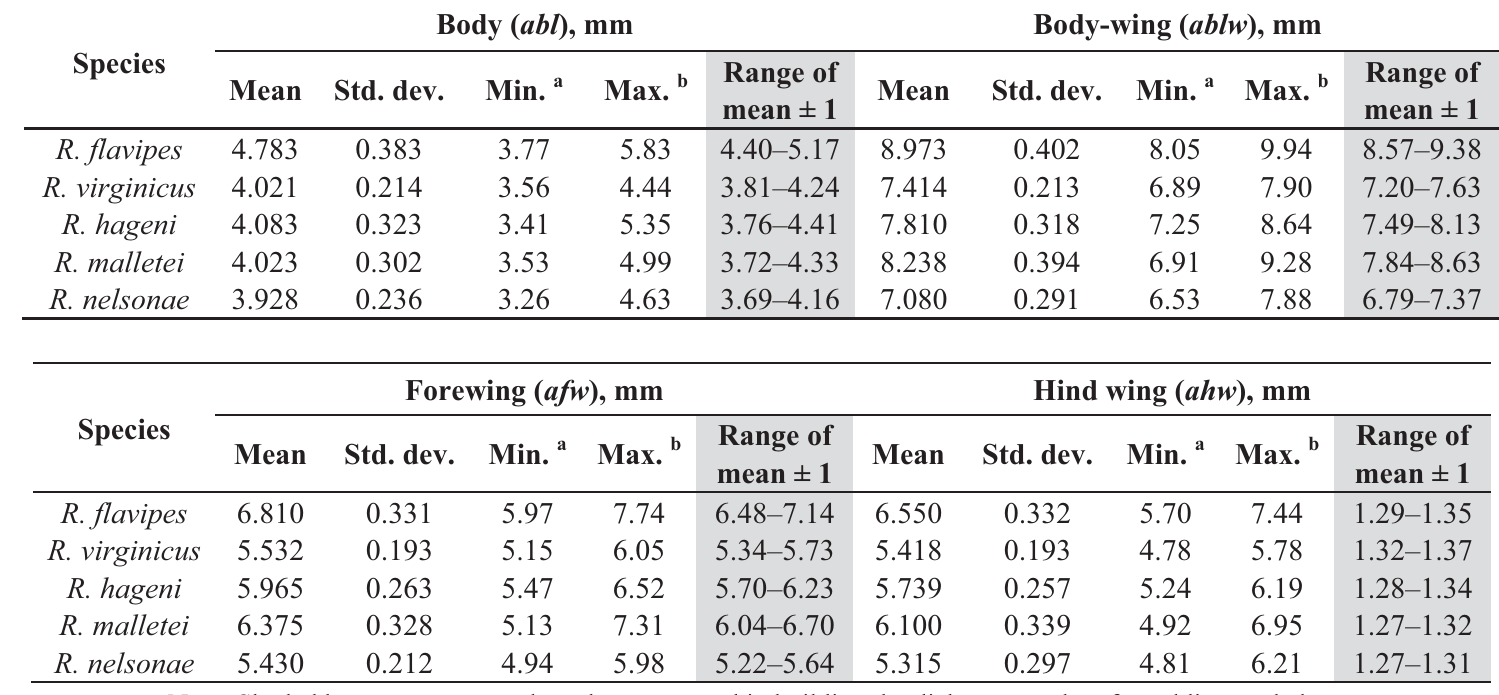
Note: Shaded boxes represent values that were used in building the dichotomous key for soldiers and